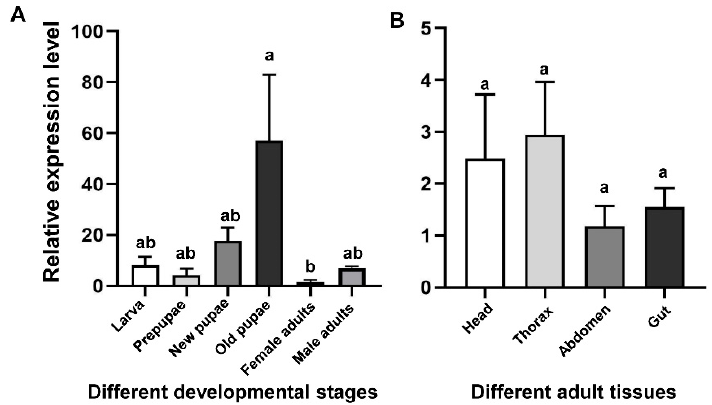
Figure 2. Transcript relative expression analysis of CHS2 in L. trifolii at different developmental stages ( A ) and adult tissues ( B ). Different lowercase letters in panels indicate significant differences between treatments. Tukey’s multiple range test was used for pairwise comparison of means ( p < 0.05).